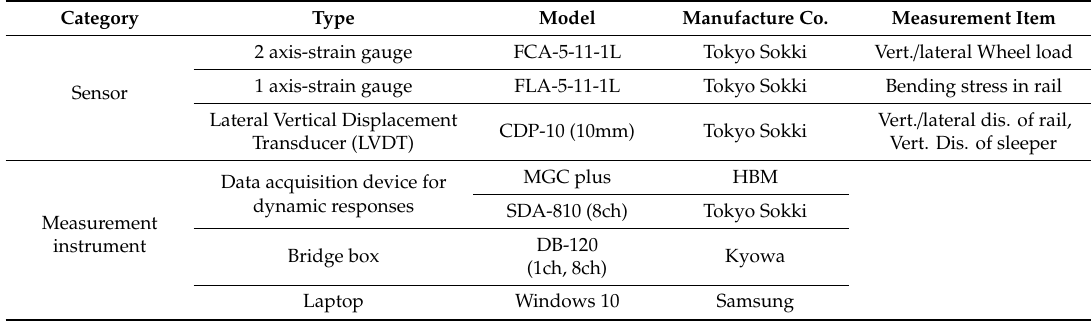
Table 5. Field instrumentation equipment for trackside